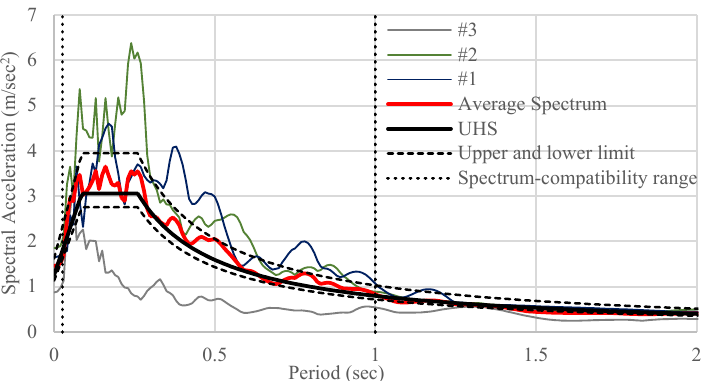
Figure 8. Response spectra corresponding to the horizontal components of the spectrum-compatible. Upper and lower limits represent 130% and 90% of the UHS considered in this study.